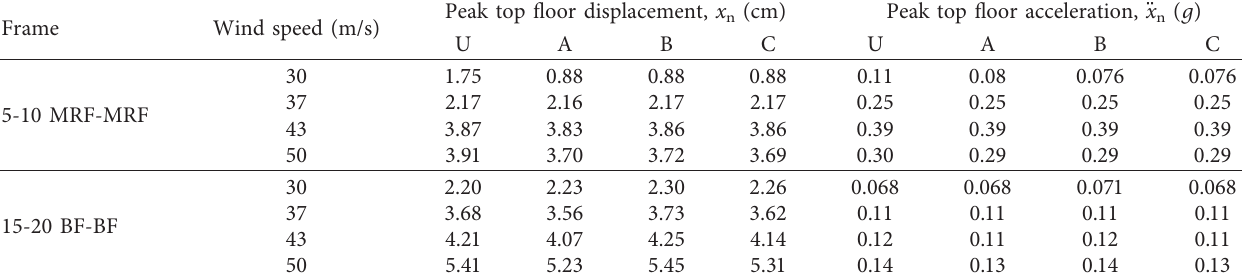
Table 11: Peak top floor displacement and acceleration responses of dissimilar connected buildings for unequal storey height under simulated wind forces for different gust